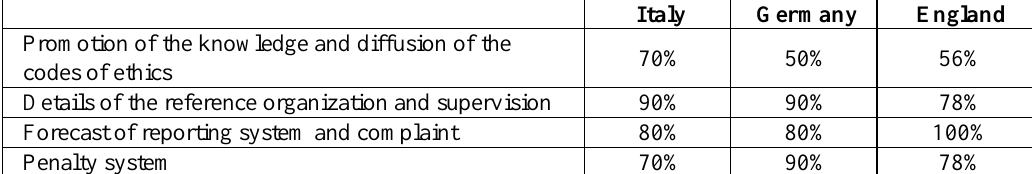
Table 13: The Implementation Details of Code Conditions Promotion of the knowledge and diffusion of the codes of